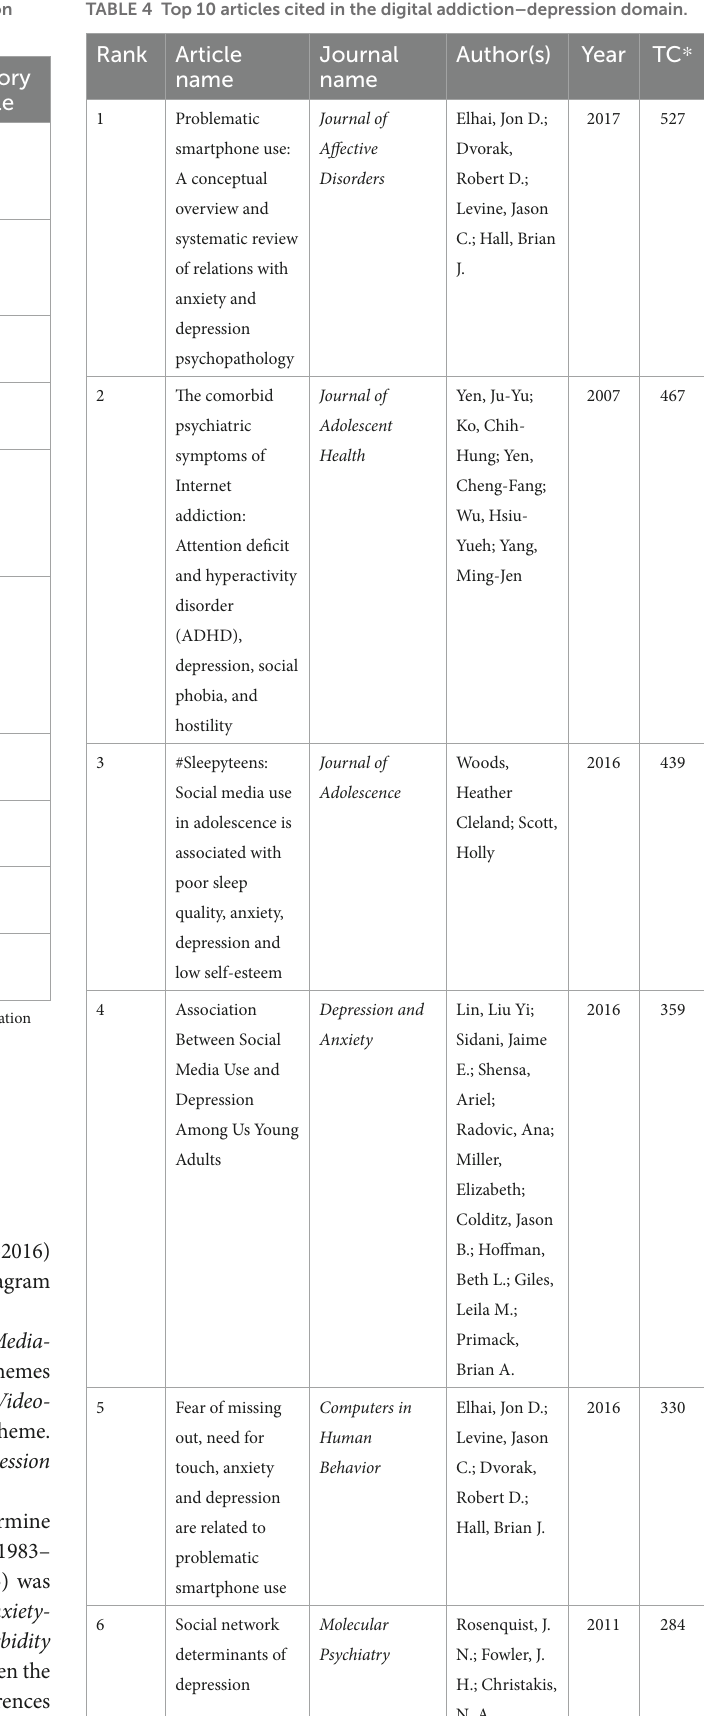
TABLE 4 Top 10 articles cited in the digital addiction–depression